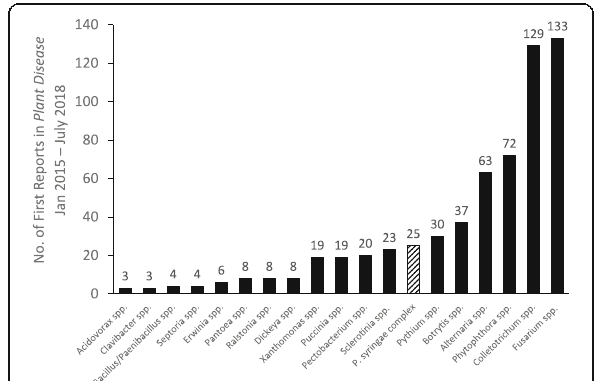
Fig. 1 Number of First Reports in the journal Plant Disease , from Jan 2015 to July 2018, than concern species in the Pseudomonas syringae complex (hashed bar) relative to other pathogens (black bars) in a total of 1862